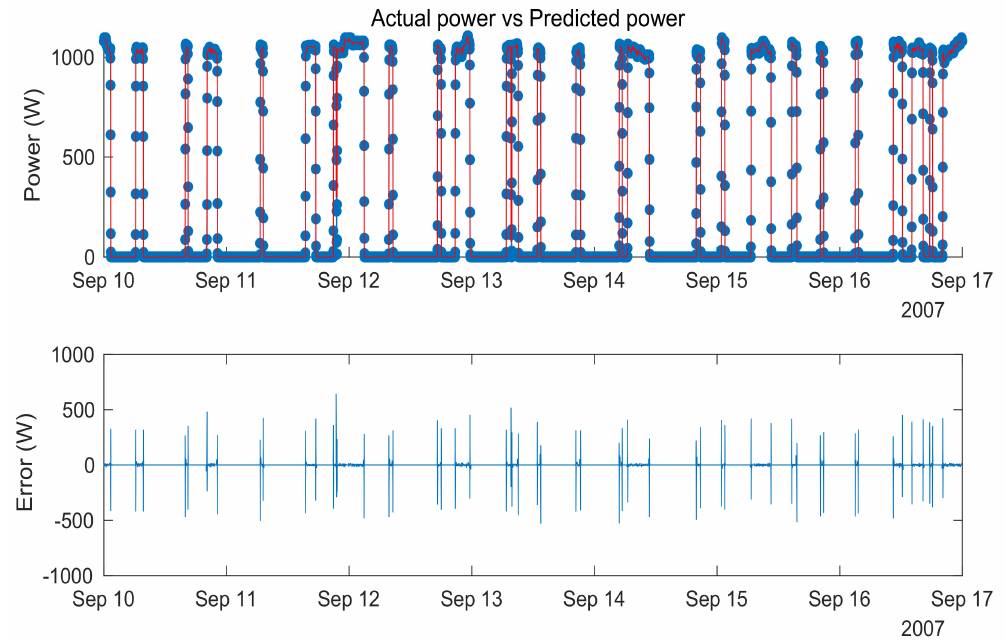
Figure 11. Results of the regression tree for one week of